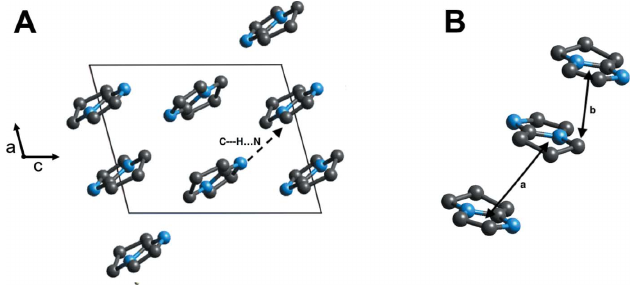
Figure 3 Packing diagram for ( II ) projected along the b axis (A), and the intermolecular arrangement and distance of ( II ) found in the crystal structure (B) (a shows the centroid-to-centroid distance, b the centroid- to-atom distance). Hydrogen atoms were omitted for clarity.